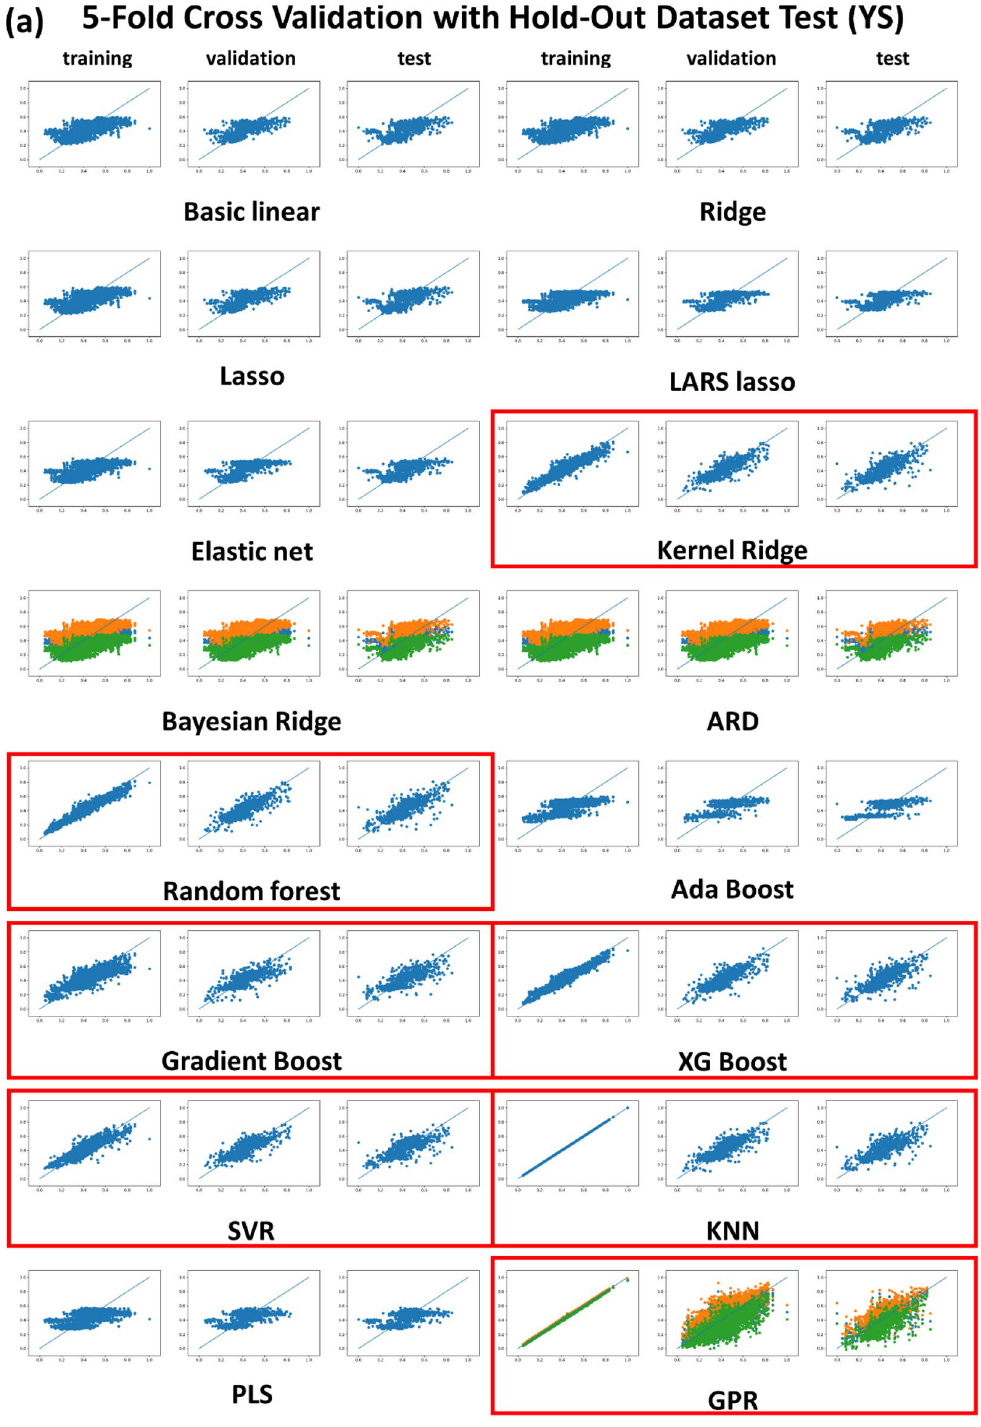
Figure 2. Plots of predicted vs. experimental ( a ) YS and ( b ) UTS for training, validation and hold-out test datasets for 5-fold cross